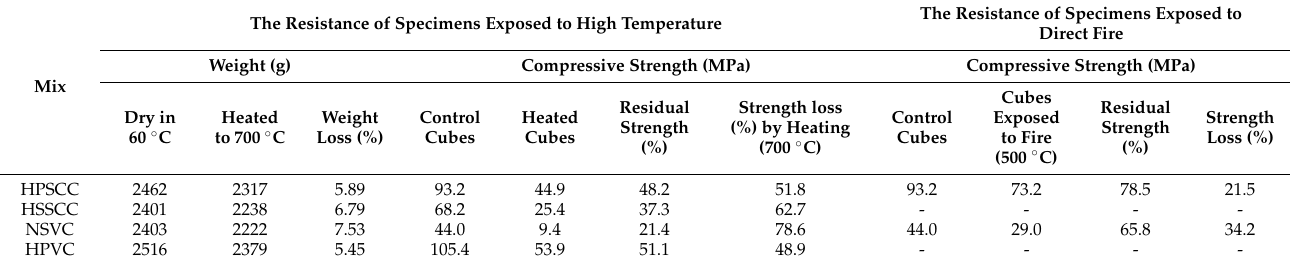
Table 8. Resistance of specimens exposed to high temperature, and specimens exposed to direct fire.